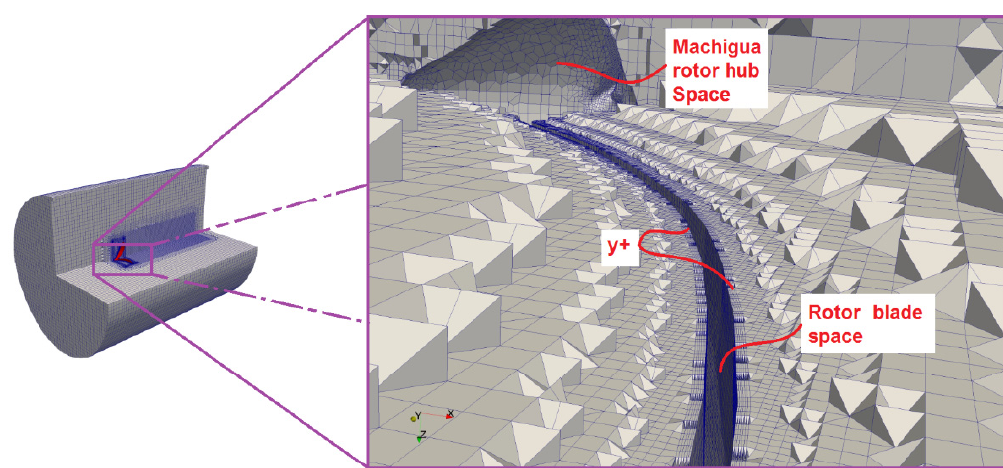
Figure 10. Mesh configuration details for Machiguá wind rotor.